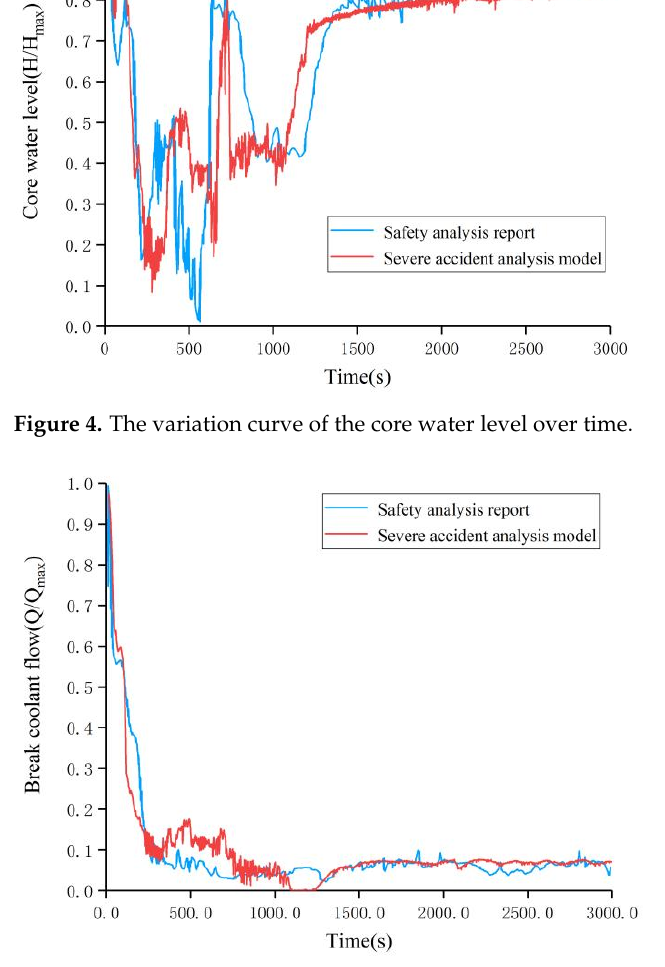
Figure 5. The variation curve of the break coolant flow over time.